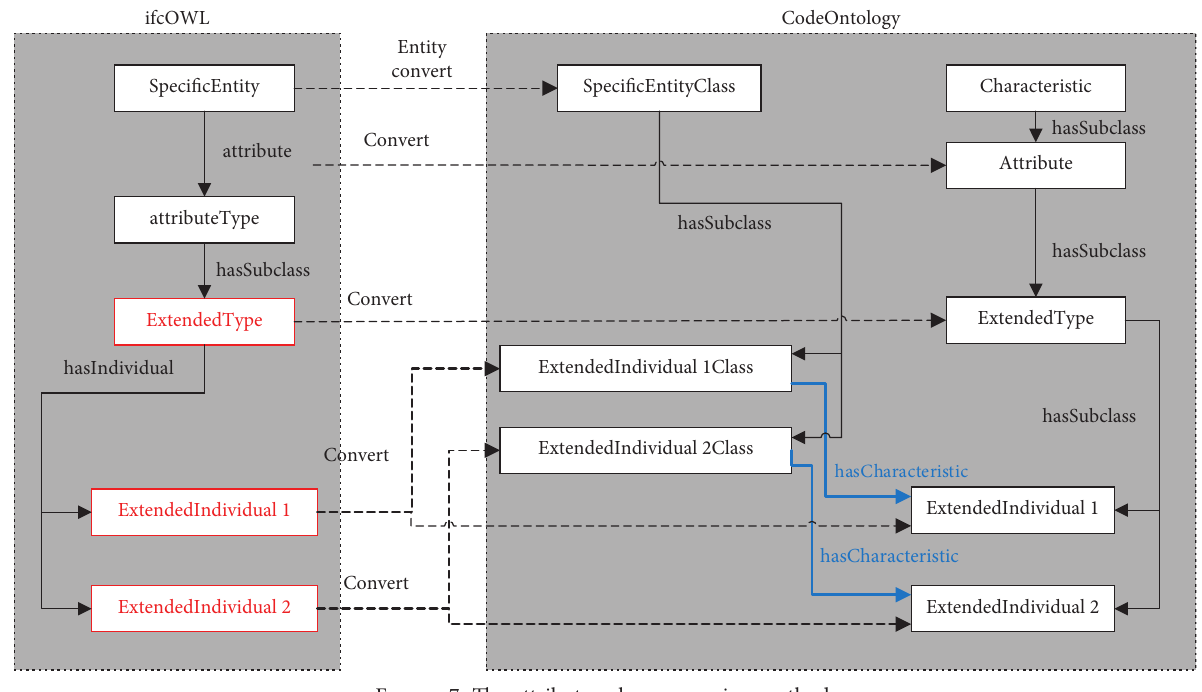
Figure 7: The attribute value conversion